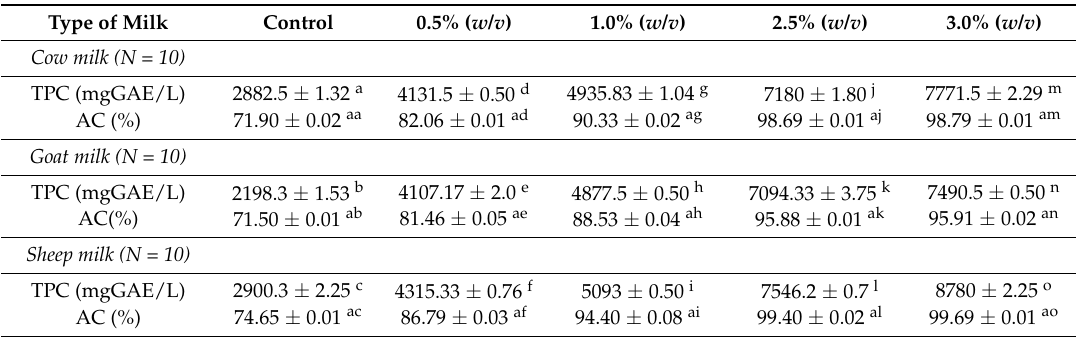
Table 3. Total phenolic content and in vitro antioxidant capacity of bee pollen enriched yoghurts with respect to milk